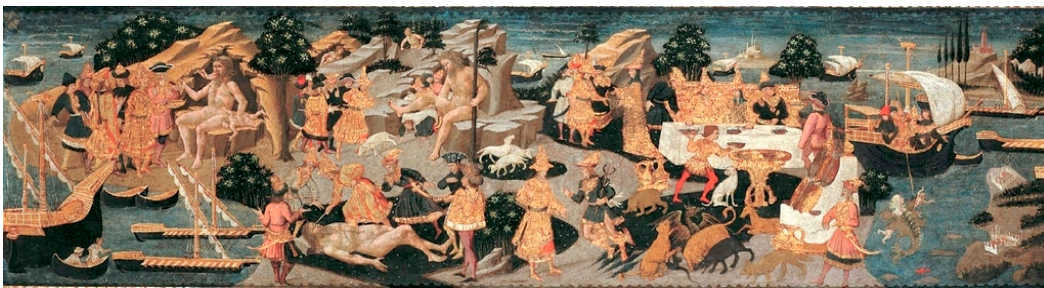
Figure 1. Apollonio di Giovanni, The Adventures of Odysseus (1435–40), cassone front, tempera on panel (by permission of The Art Institute of Chicago/Art Resource, NY).